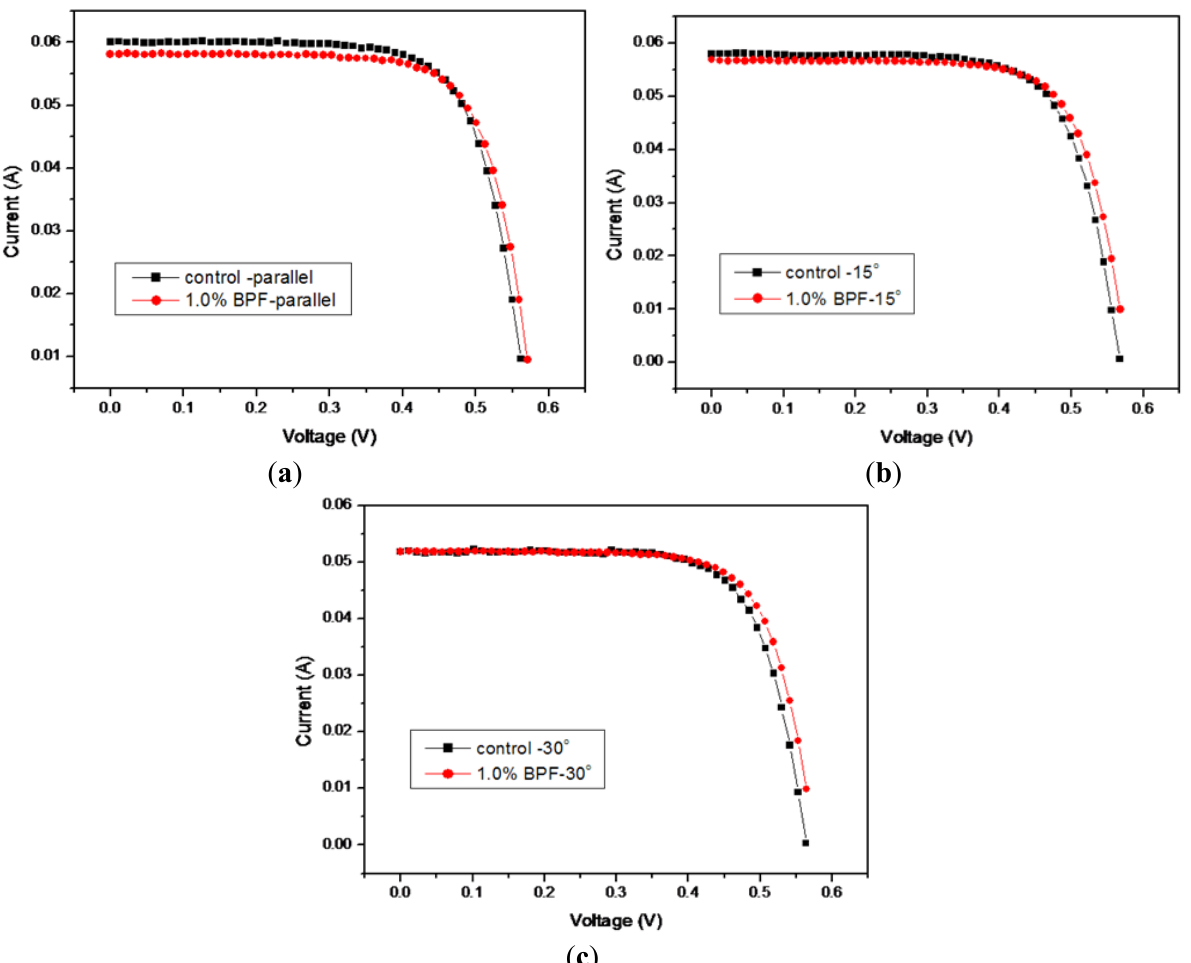
Figure 1. The measured I–V curves for the coated solar cell samples using 1% reactive mesogen liquid crystal precursor solution. The light incident angle was 0° for ( a ); 15° for ( b ); and 30° for ( c ). The control solar cell sample data are also included for the ones without the liquid crystal polymer